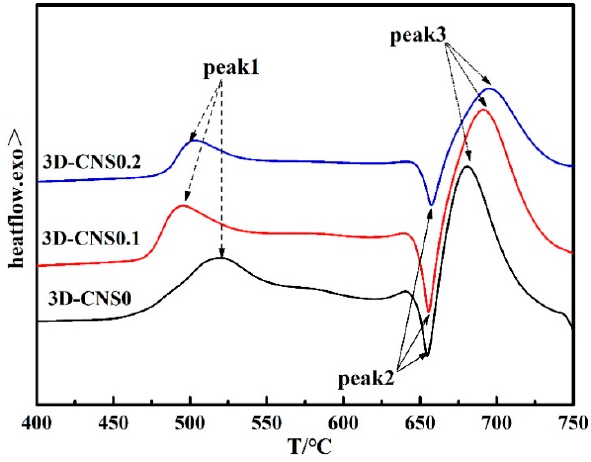
Figure 4. The measured DTA curves for pure and 3D-CNS doped MgB 2